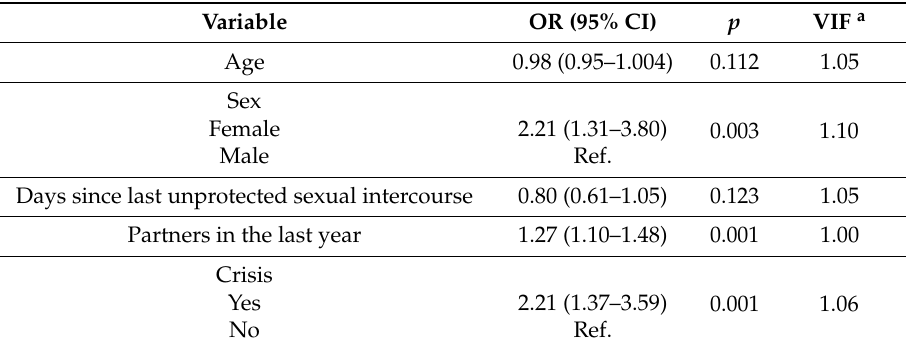
Table 4. Logistic Regression Model for Sexually Transmitted Infection (STI) Diagnosis.